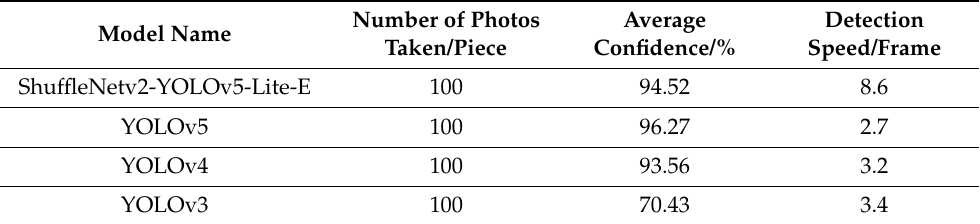
Table 2. Identification comparison